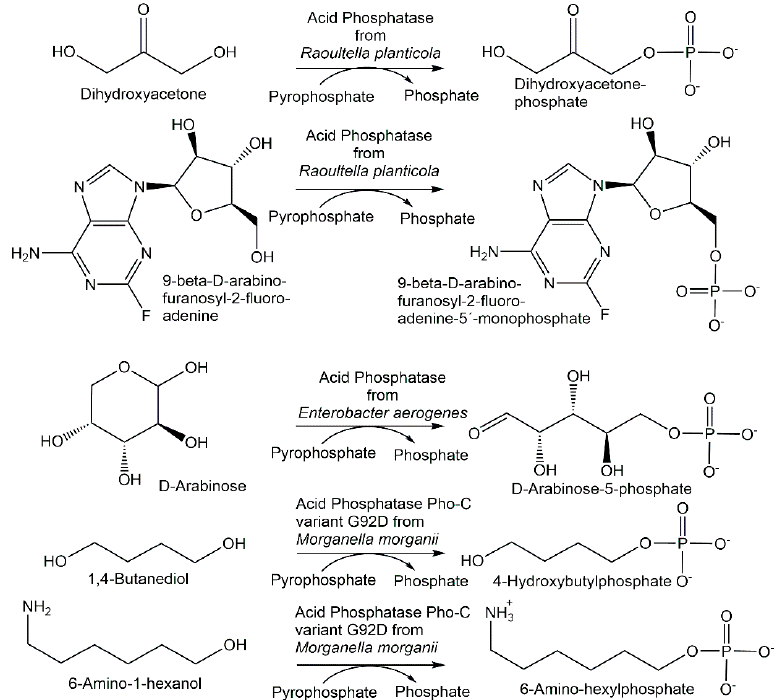
Figure 8. Novel phosphohydrolases for phosphorylation reactions.